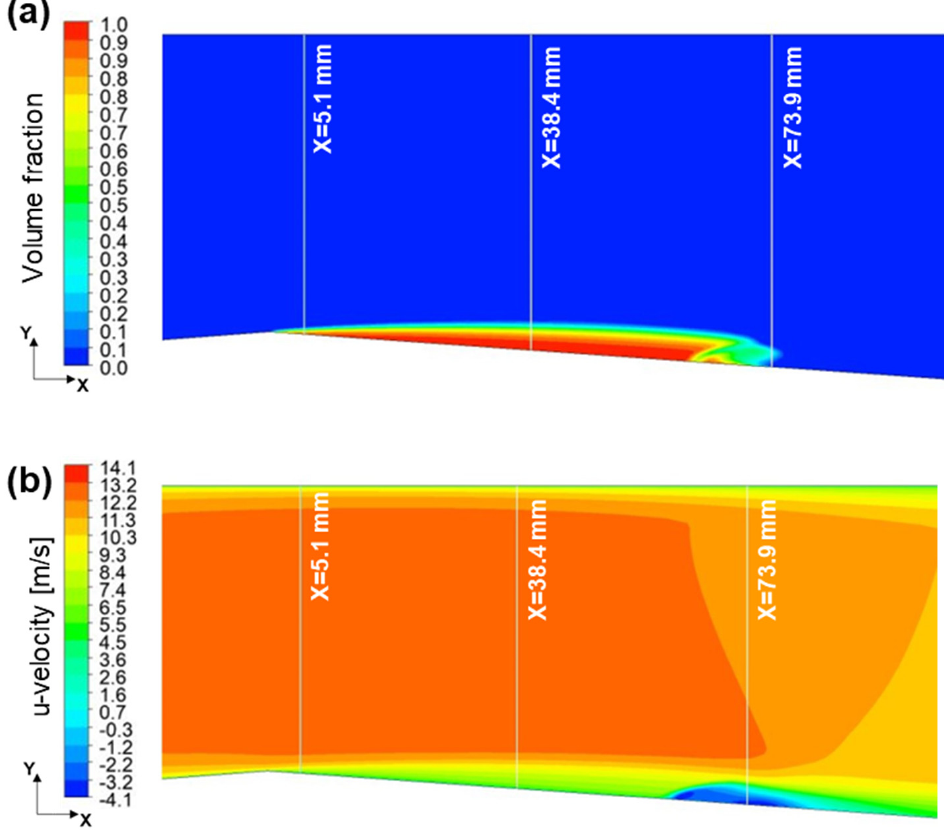
Figure 3. ( a ) Void fractions and ( b ) u-velocity contour .